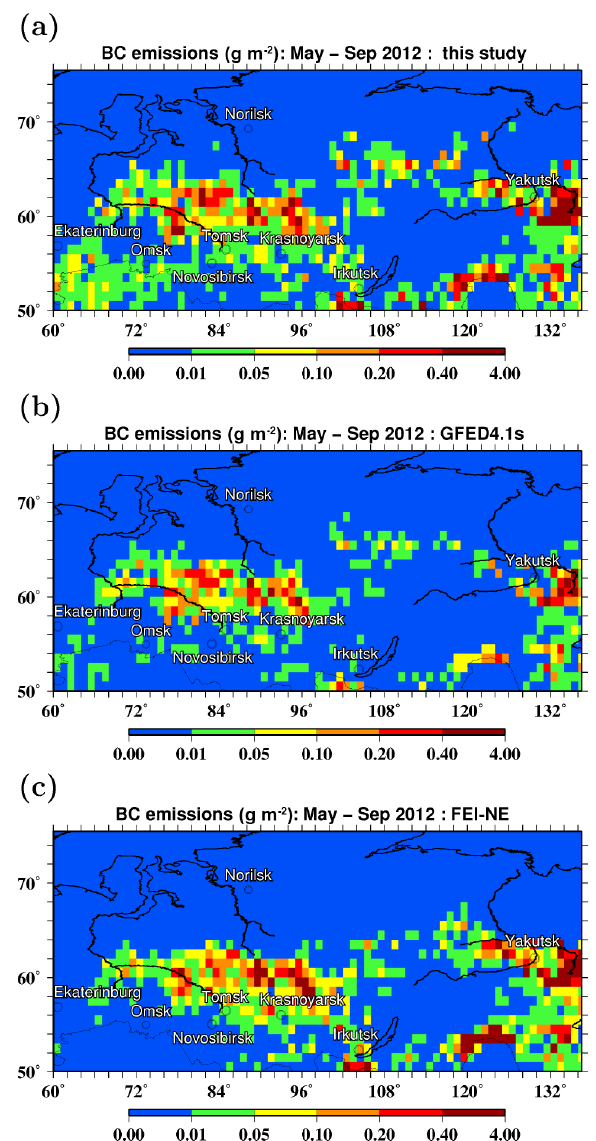
Figure 11. Gridded estimates of the BB BC emission totals (gm − 2 ) obtained in this study (a) and those calculated using GFED4.1s (b) and FEI-NE (c) data for the period from 1 May to 30 Septem- ber